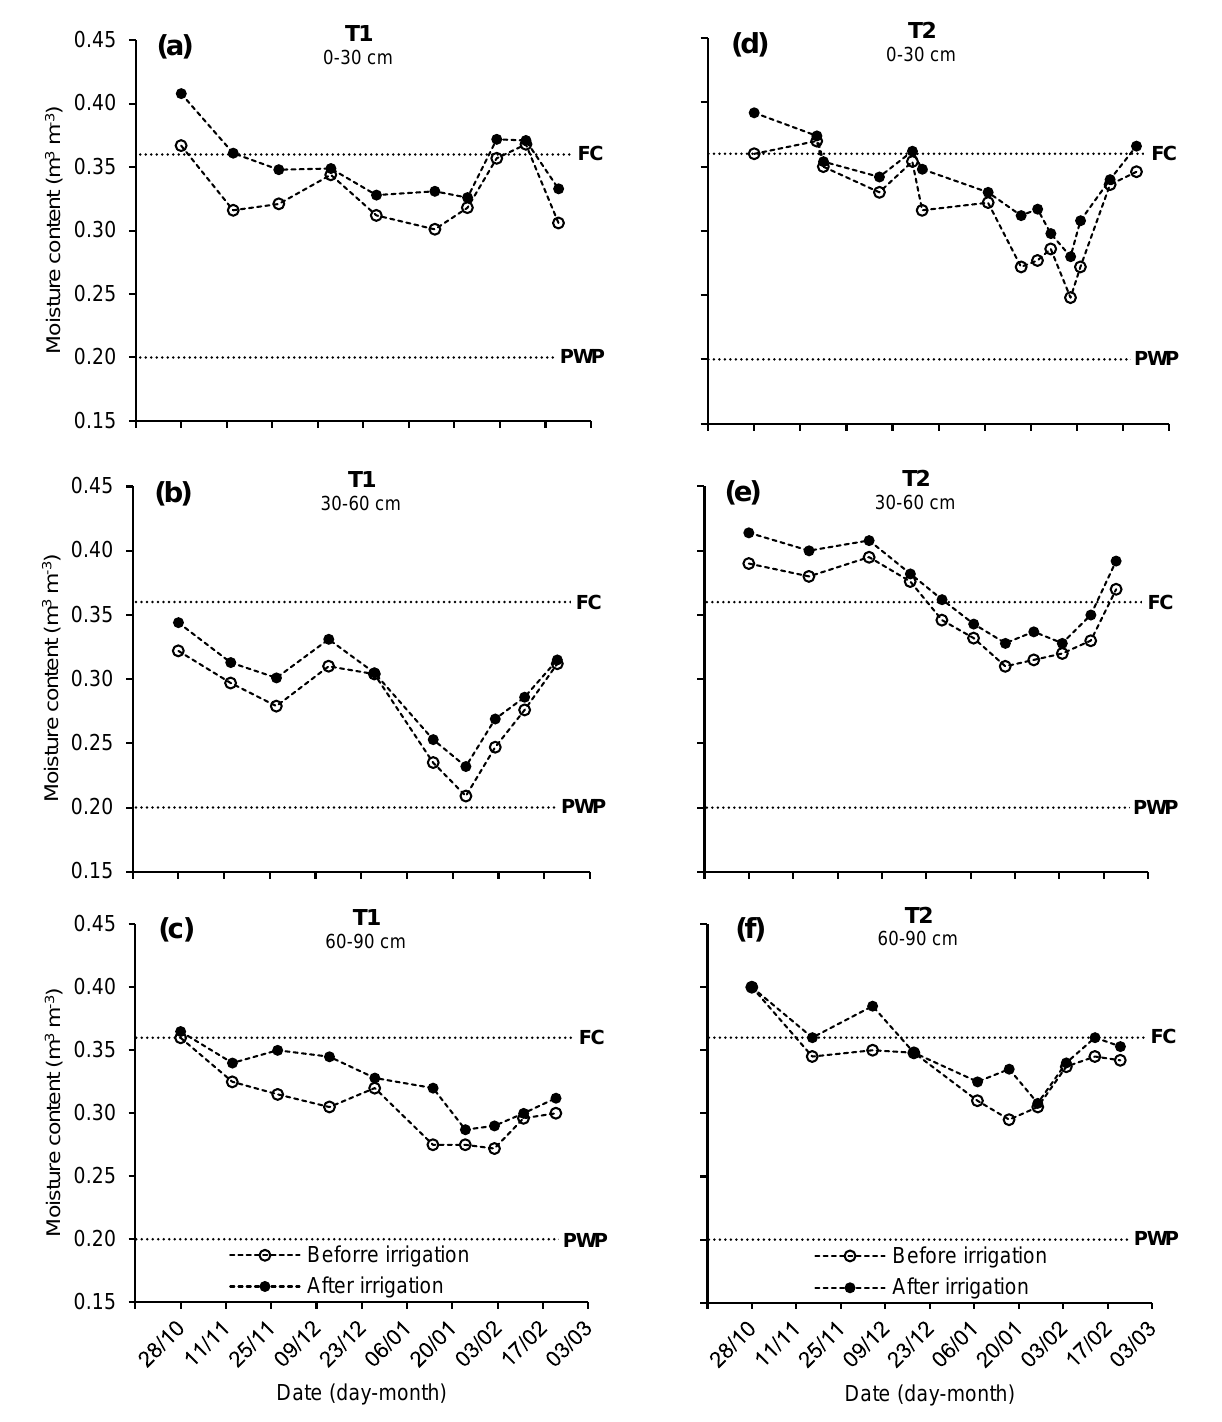
Figure 6. Cycles of soil moisture content before and one day after irrigation in the ( a , d ) 0–30 cm, ( b , e ) 30–60 cm, and ( c , f ) 60–90 cm strata throughout the 2009–2010 irrigation season for two microjet irrigation treatments of ‘Royal Gala’ apple trees. T1: Irrigation with theoretical volume required by the plant. T2: Irrigation with farm protocol. Each point is the average of 12 readings. FC is field capacity and PWP is permanent wilting point.